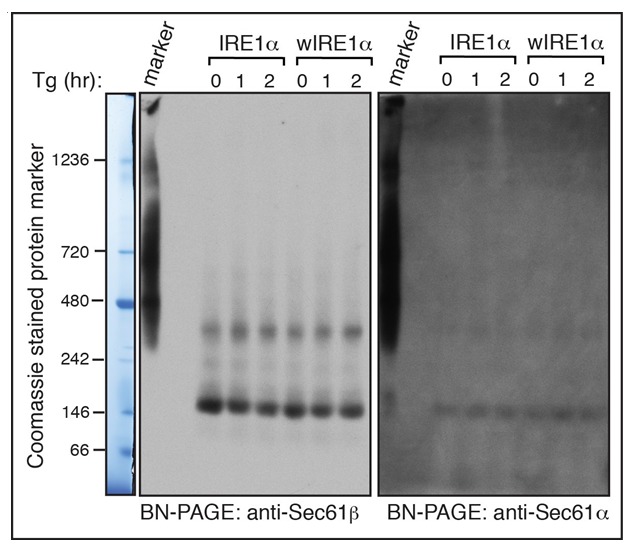
BN-PAGE immunoblotting analysis of the Sec61 translocon complex.IRE1α -/- HEK293 cells complemented with wild-type IRE1α-HA or wIREα-HA were treated with 2.5 μg/ml Tg for the indicated hours (hr), lysed with digitonin, and analyzed by BN-PAGE immunoblotting as well as a protein marker lane from the same BN-PAGE gel was excised.